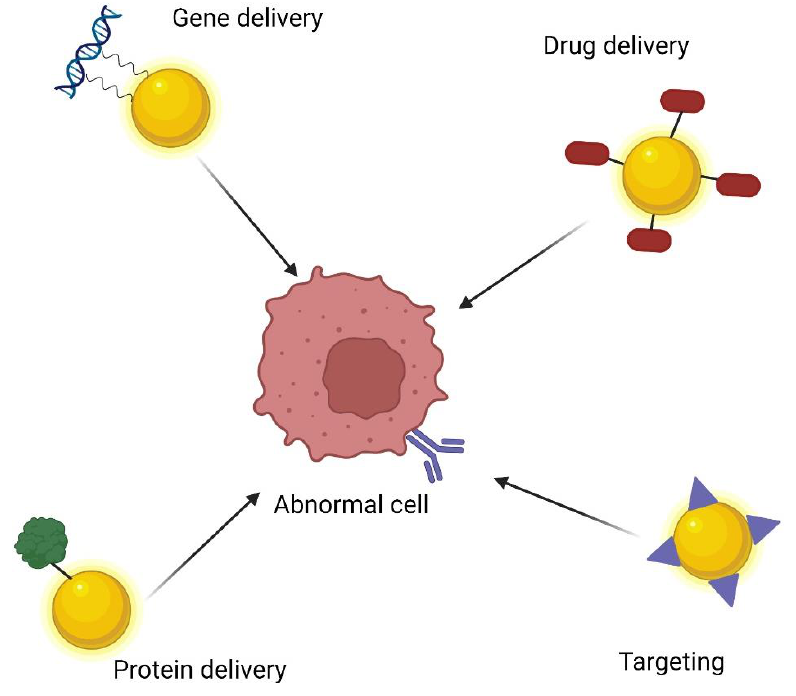
Figure 6. Gold nanoparticles as carriers of various compounds. Figure 6 . Gold nanoparticles as carriers of various compounds .